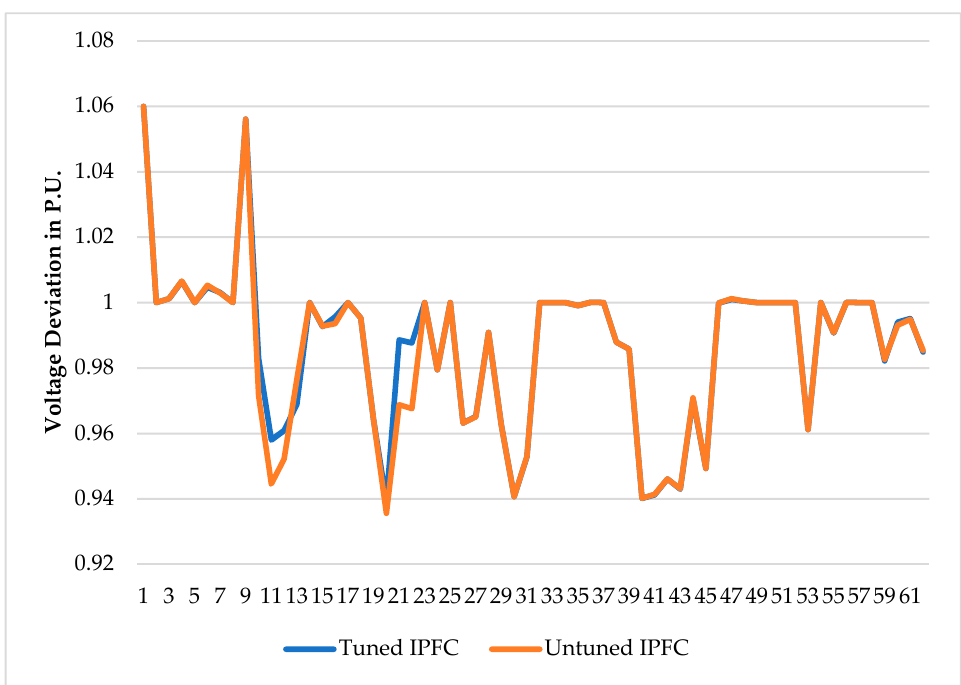
Figure 9. Voltage Deviation at the buses for the 62 ‐ bus system.